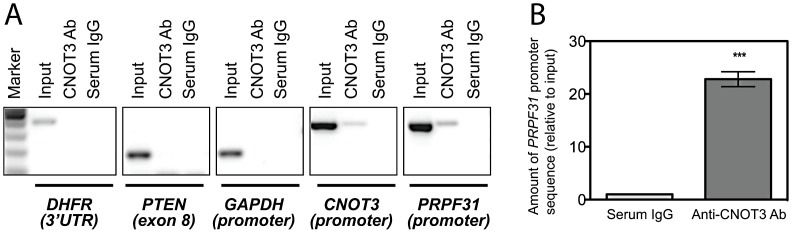
CNOT3 binds to the PRPF31 promoter in cells.(A) CNOT3 ChIP-PCRs on different target sequences. Enrichment is visible only for PRPF31 promoter and CNOT3 promoter (positive control); DHFR 3′UTR, PTEN exon8, and GAPDH promoter sequences are all negative controls. (B) CNOT3 ChIP-q-PCR on PRPF31 promoter sequence. Error bars indicate the standard deviation of the mean for three independent ChIP-qPCR experiments. Serum IgG is used as IP negative control. ***, p<0.001.